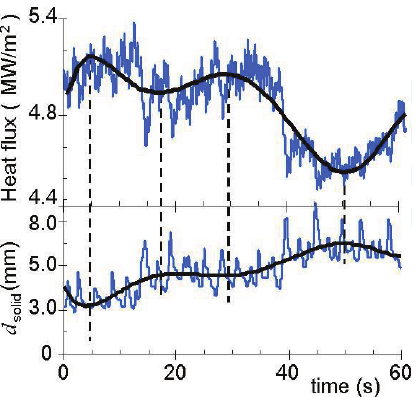
Figure 10. Heat flux and solid slag film thickness ( d solid ) as functions of time (100 cycles) V c D 0:6 m min (cid:3) 1